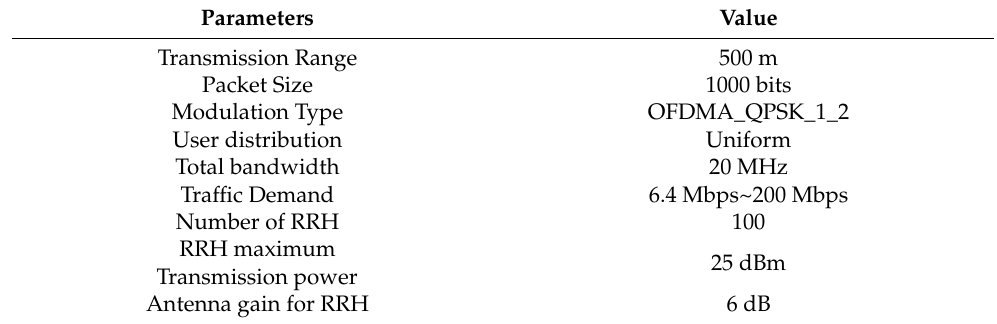
Table 3. Simulation